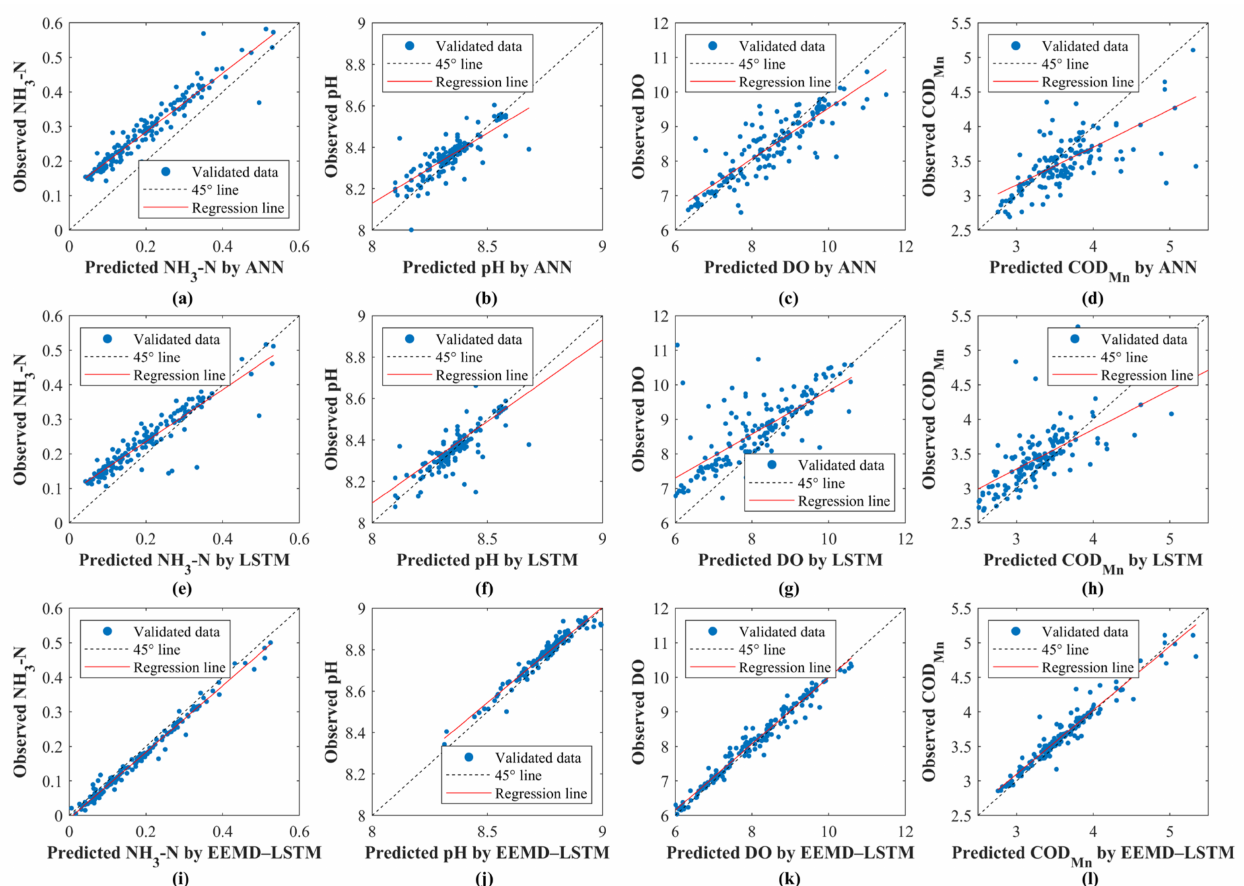
Figure 9. Scatterplot of the observed and predicted values by ANN, LSTM, and EEMD–LSTM in the validation period. ( a – d ) represent the observed and predicted values of NH 3 -N, pH, DO, COD Mn by ANN, respectively. ( e – h ) represent the observed and predicted values of NH 3 -N, pH, DO, COD Mn by LSTM, respectively. ( i – l ) represent the observed and predicted values of NH 3 -N, pH, DO, COD Mn by EEMD–LSTM,